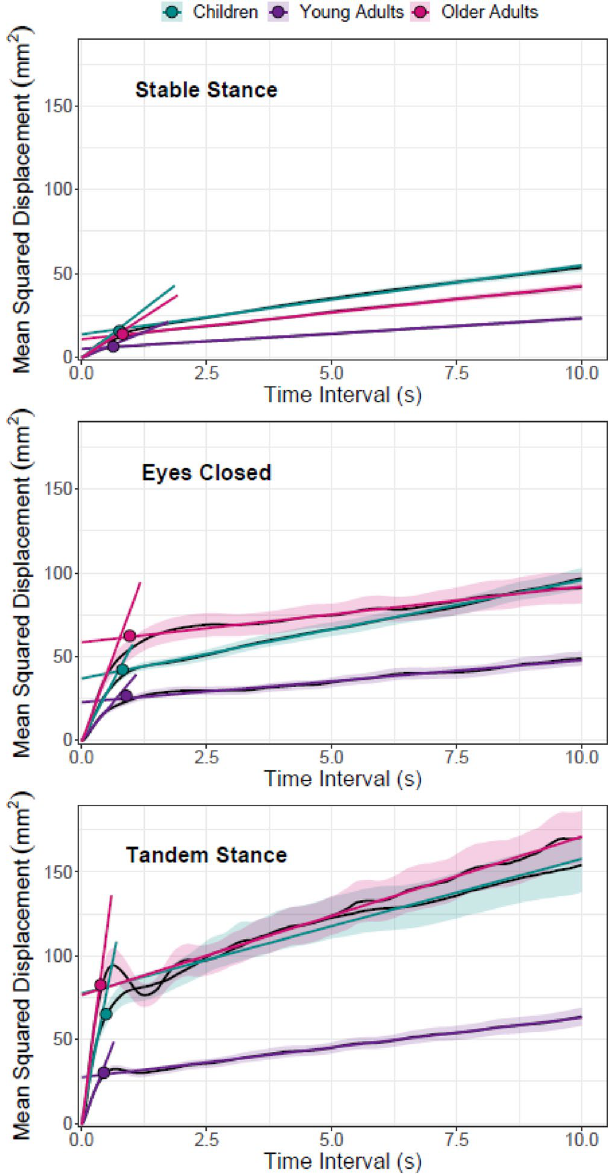
Figure 2. Averaged stabilogram diffusion plots with fit lines based on parameter estimates for short- and long-term diffusion coefficients in stable stance, eyes closed and tandem stance conditions. Symbols denote the critical point. Error envelope = ±